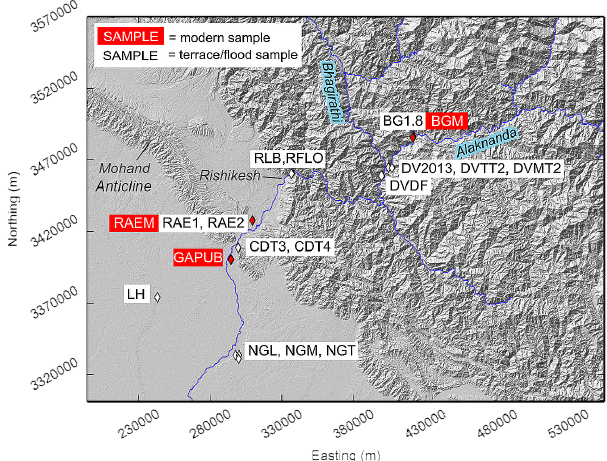
Figure 3. Modern (red) and terrace/floodplain/flood (white) sample locations and names in the lower Ganga catchment. See Table 1 for full description of